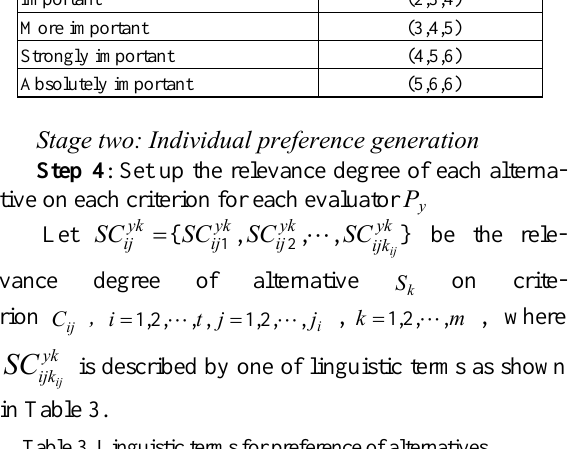
Table 3. Linguistic terms for preference of